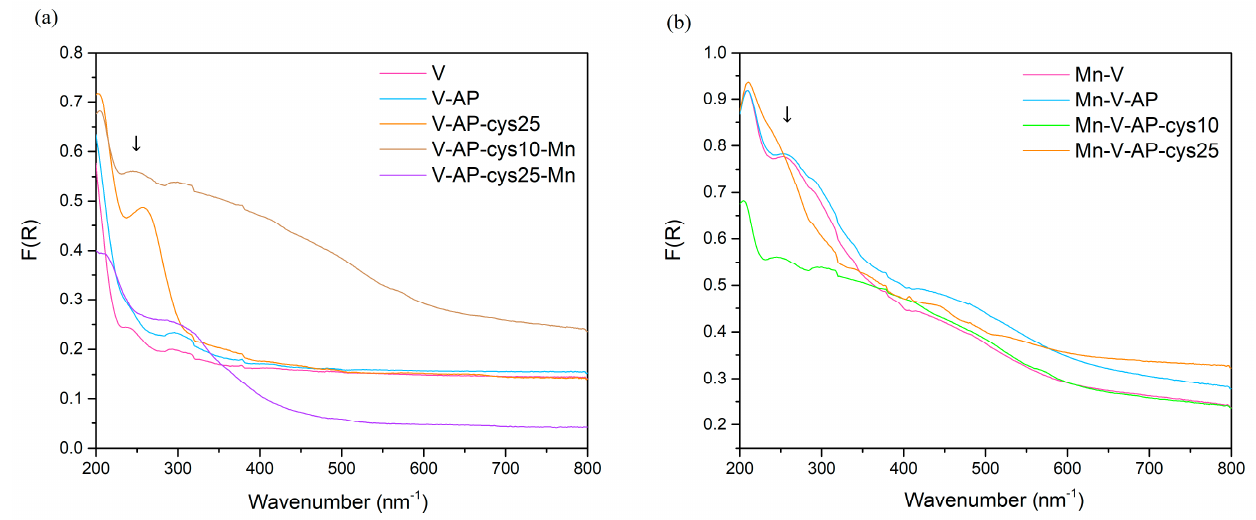
Figure 2. Comparative ultraviolet-visible spectra for ( a ) V series, ( b ) Mn-V series.